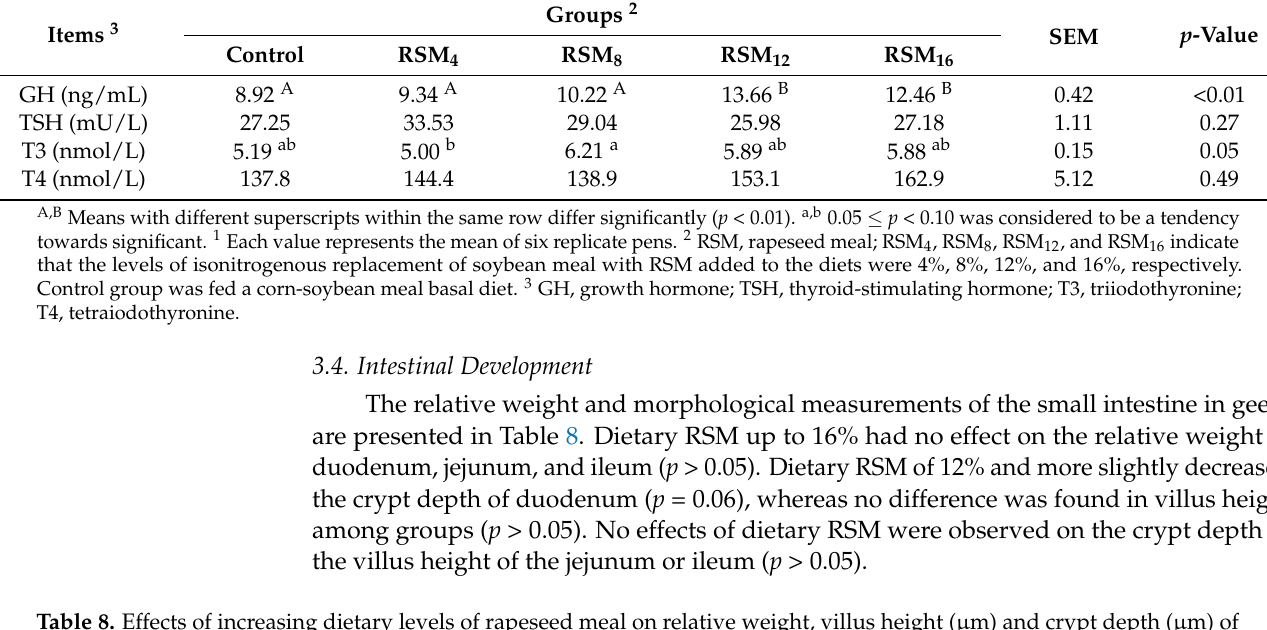
Table 8. Effects of increasing dietary levels of rapeseed meal on relative weight, villus height ( µ m) and crypt depth ( µ m) of geese at 70 d of age 1